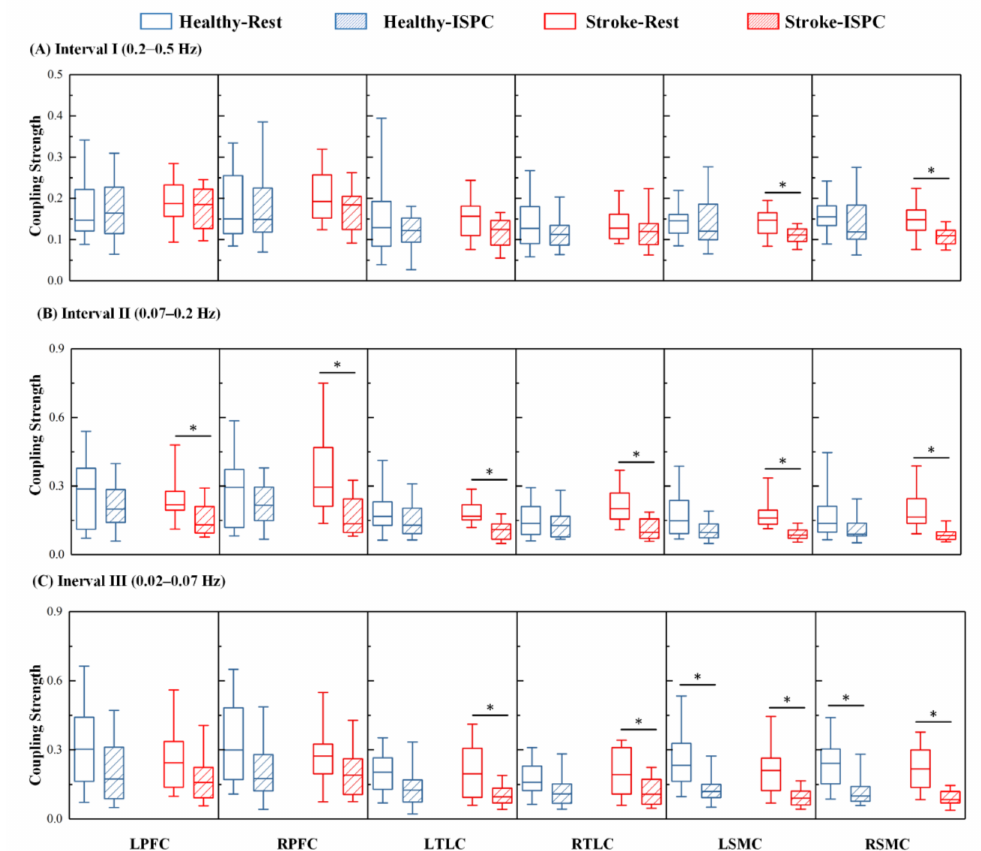
Figure 5. Comparison of region-wise coupling strength and the associated standard deviations from ABP to ∆ [O 2 Hb] signals for each group in each state is shown in ( A ) interval I, ( B ) interval II, and ( C ) interval III. Error bars represent the standard deviations of the measurements. Significant differences are marked with ∗ ( p <